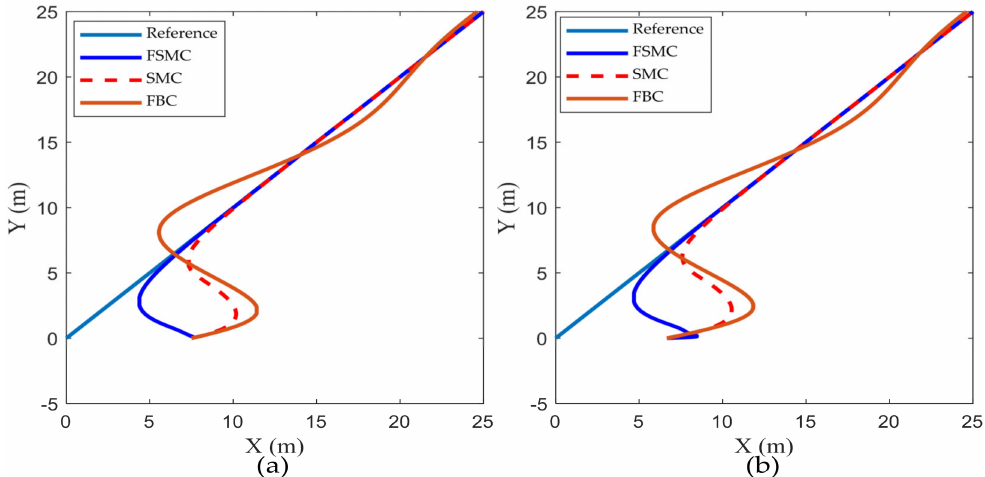
Figure 4. The path tracking trajectories of the tractor-trailer: ( a ) the trajectory of the tractor; ( b ) the trajectory of the trailer.